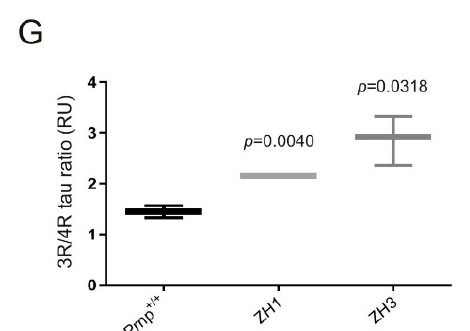
Figure 1. Effects on tau and its alternative exon 10 isoforms in mice devoid of PrP C expression. ( A – C ) Total tau expression analyzed in brain extract from WT and Prnp 0/0 mice ZH1 or ZH3 at the age of 3 months. ( A ) Representative WB analysis using total anti-tau antibody (monoclonal Tau5) in parallel with anti-PrP C antibody (monoclonal 6H4) in each case. Actin detection was used as control loading protein. ( B ) Histograms showing the densitometry study of tau expression in each genotype. ( C ) Histograms showing the RT-qPCR analysis of expression of tau in mice analyzed in ( A ). ( D – G ) 3R and 4R tau isoform expression analyzed in brain extract from WT and Prnp 0/0 mice ZH1 or ZH3 at the age of 3 months. ( D ) Representative WB analysis using anti-3R tau antibody (monoclonal RD3) in parallel with anti-4R tau antibody (monoclonal RD4) in each genotype. Actin detection was used as control loading protein. ( E , F ) Histograms showing the densitometry study of 3R tau ( E ) or 4R tau ( F ) expression in each genotype. ( G ) Graphical representation of the 3R/4R tau ratio analyzed with data represented in ( E , F ). Between 3 and 5 mice were examined in each group and data represents the mean ± S.E.M. Differences between groups were considered statistically significant at ** p < 0.01 and * p < 0.05 ( t -test).